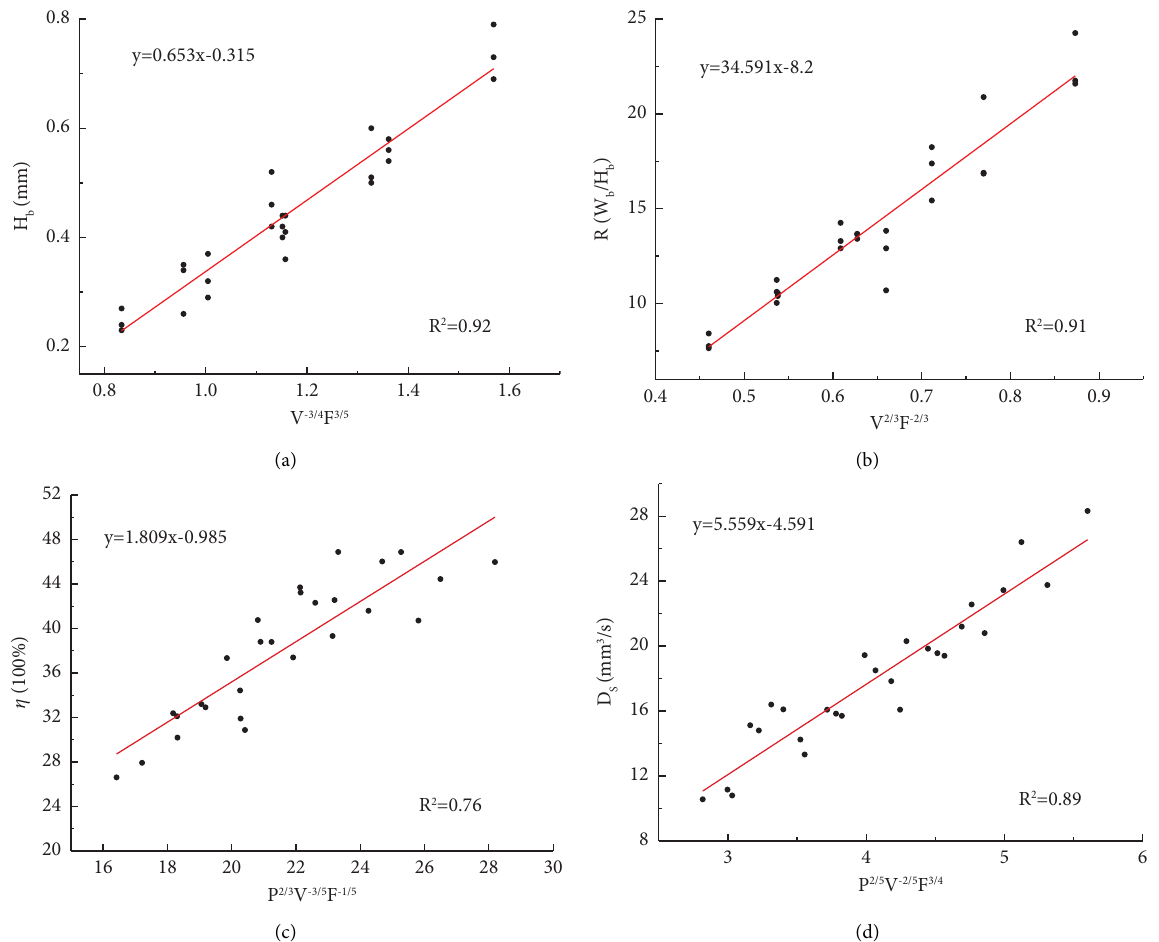
Figure 11: Linear ftting relationship between combined parameters and the bead characteristics: (a) H